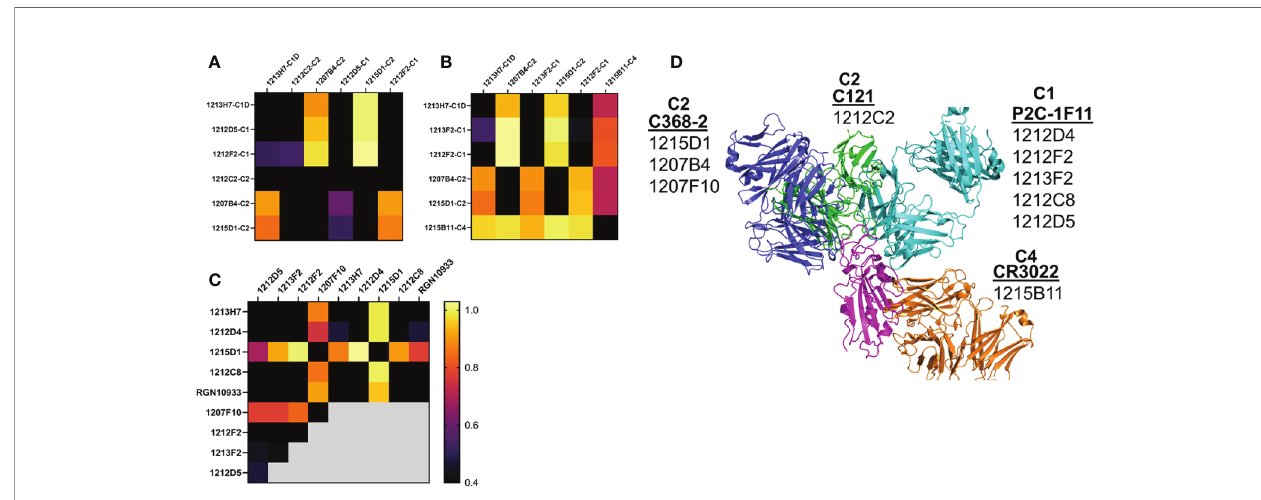
FIGURE 7 | NAb epitope mapping. SPR-based epitope mapping performed to further validate the classi fi cation of unknown NAbs assigned to an NAb/RBD complex ( Table 1 ). (A – C) represent 3 distinct mapping experiments performed with common and distinct NAbs. (D) Graphical summary, showing NAb/RBD complexes that were assigned to the unknown NAbs and used to explain the epitope mapping data. P2C-1F11/RBD was used to model C1 NAbs, C2 NAbs were modeled by C368-2/RBD (1215D1, 1207B4 and 1207F10) and C121/RBD (1212C2) structures, while the C4 NAb, 1215D11, was modeled by the RBD/CR3022 structure. The assigned structures explain how 1212C2 epitope blocks all other NAbs from binding to RBD, while 1212D4 (or 1213H7) and 1215D1 bind to non- overlapping RBD epitopes and also bind to all RBD variants they were tested against ( Figure 5 ). Two NAbs evaluated in the mapping data (1213H7 and ctl RGN10933) are not listed on the graphical summary. 1213H7 and RGN10933 were both assigned as C1D NAbs, which is consistent with their common epitope mapping pro fi les, and their ability to bind simultaneously with